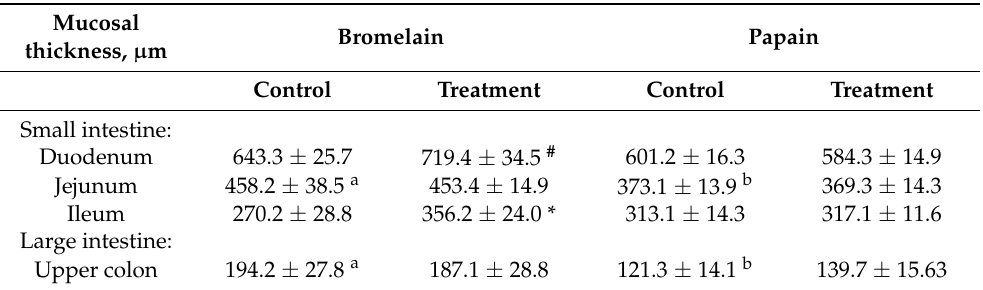
Table 1. Effect of fruit proteases feeding during a 3-day period on the mucosal thickness of the small and large intestines in